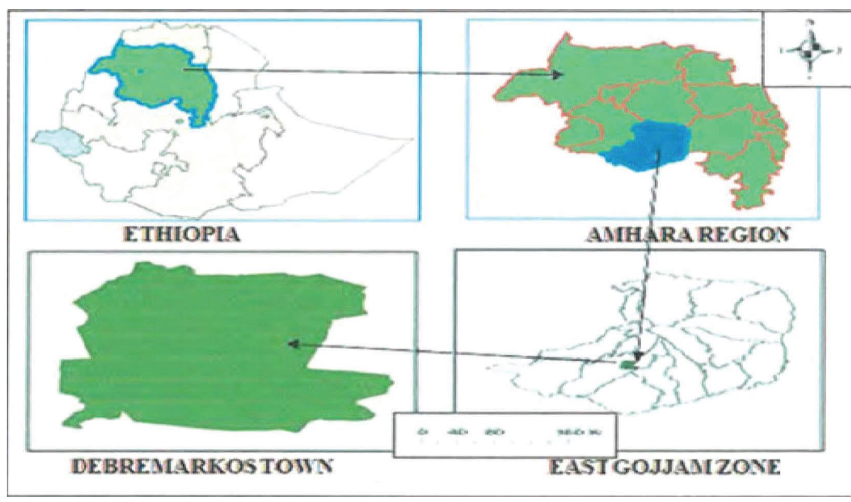
Figure 1: Location of the study area. Table 1: List of crops commonly used by the community of Debre Markos town, Northwest Ethiopia. S. No.